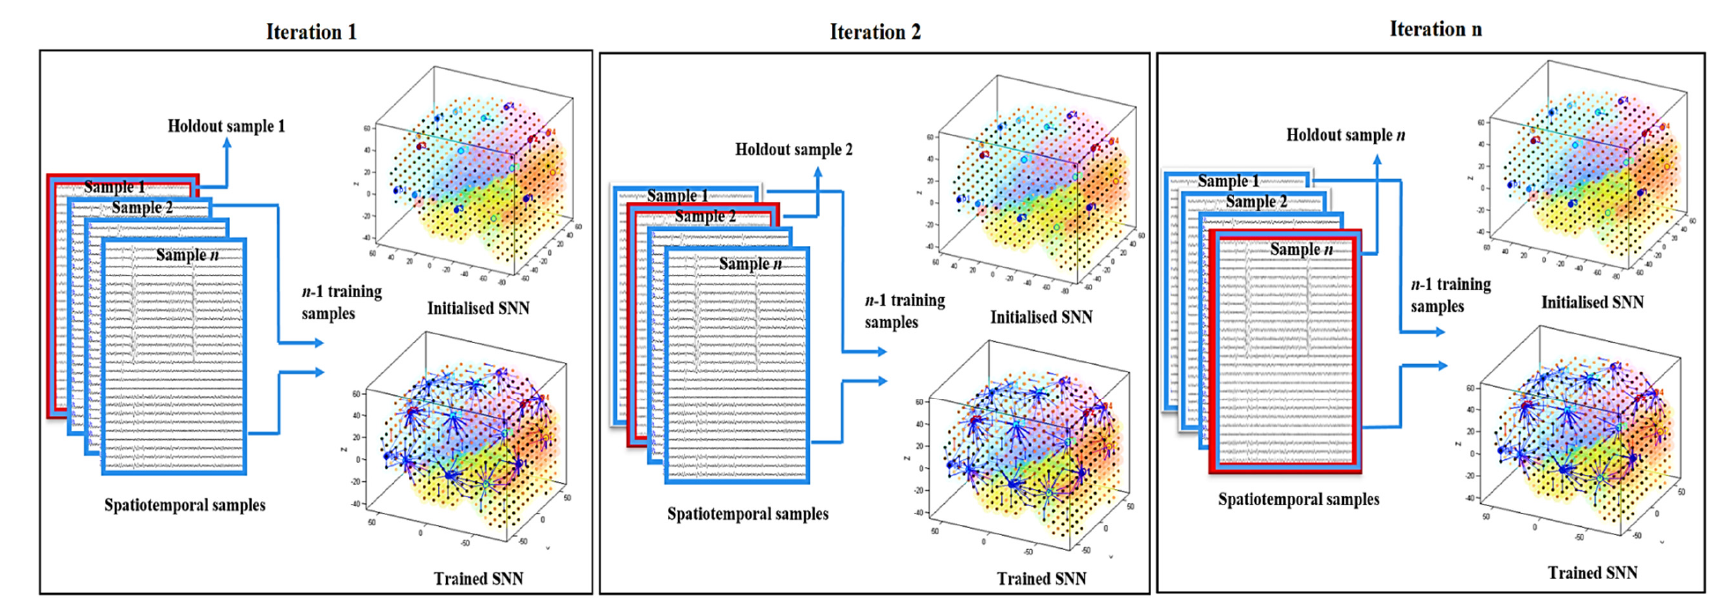
Figure 4. Iterative SNN modelling through the leave-one-out method. For n samples, the SNN model is initialised n times, and trained by a fold of different ( n − 1) samples. Then the trained model is cross-validated by the hold-out sample.